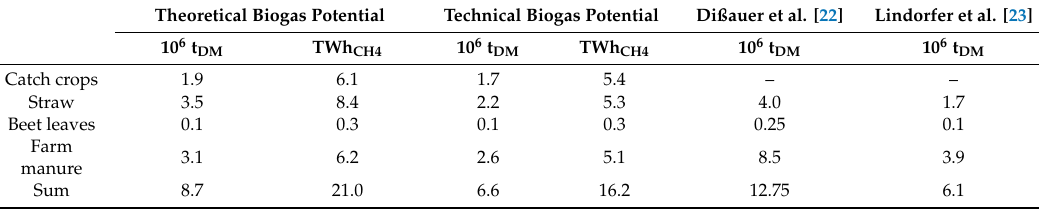
Table 3. Theoretical and technical potential compared to current potential studies in Austria. Theoretical Biogas